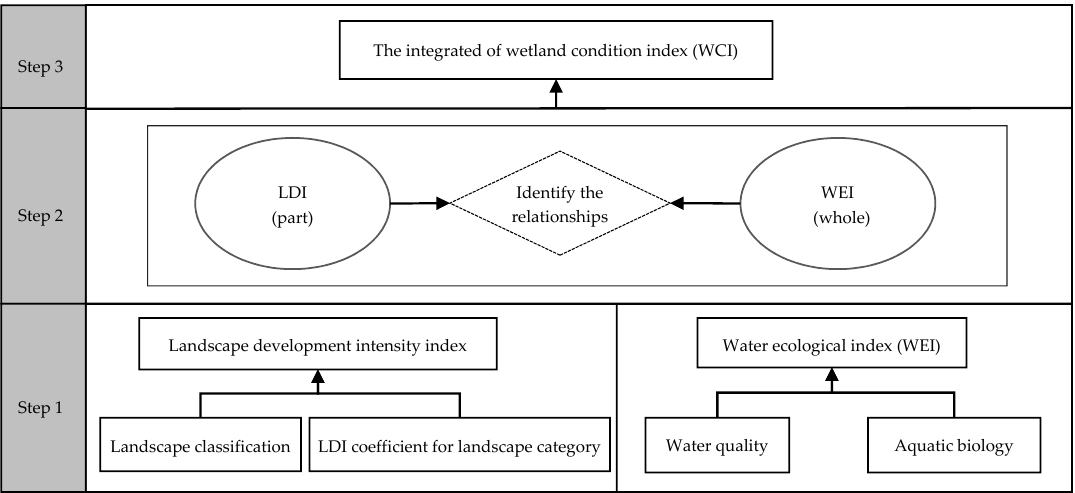
Figure 1. Methodological schema for forming the wetland condition index.